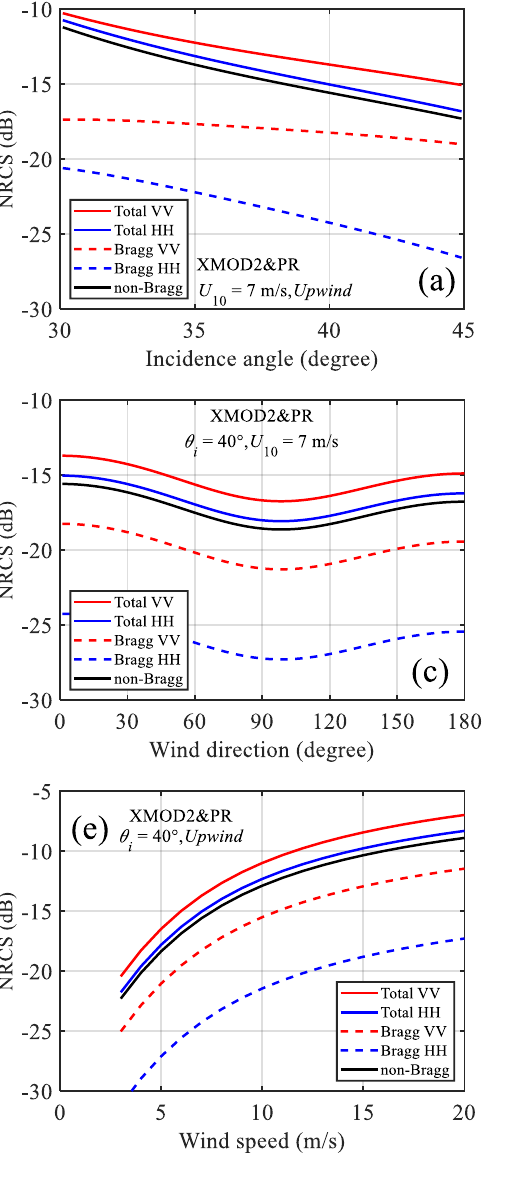
Figure 4. The NRCSs of total scattering, “pure” Bragg wave scattering and non-Bragg scattering, and the relative contribution of non-Bragg scattering estimated by using the XMOD2 and PR model. ( a , b ): with respect to incidence angles, ( c , d ) with respect to wind directions, ( e , f ): with respect to wind speeds.